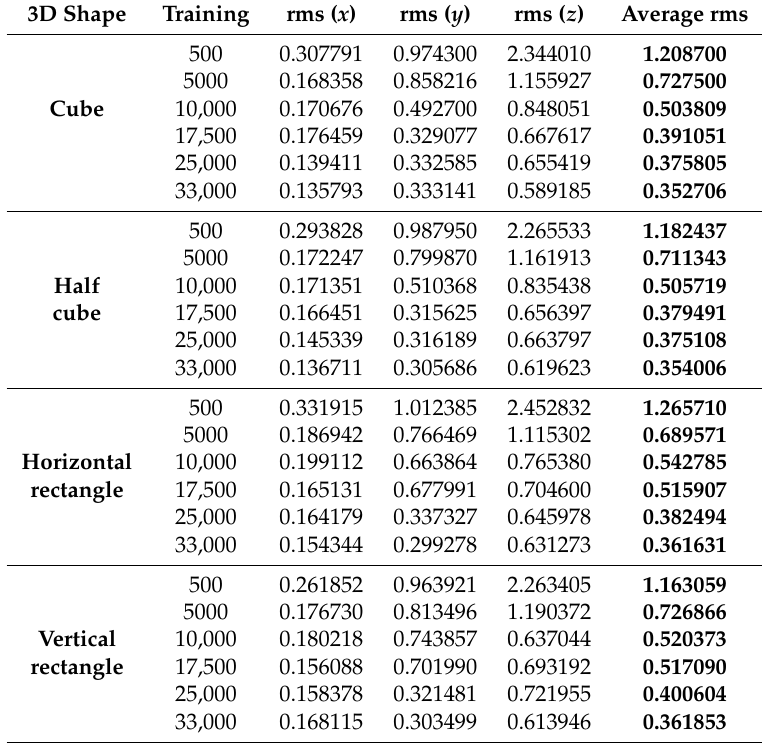
Table 3. We measured the coordinate ( x , y , z ) vertices of our HLS extraction with the ground-truth. Our CNN training used different simulated element numbers in the comparison. We measured the HLS extraction effectiveness with the root mean squared error